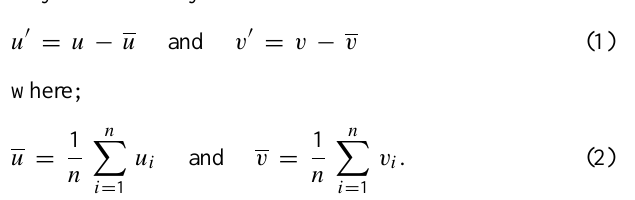
Figure 3- Sections and points of velocity measurement a) the sinusoidal ripple; b) the triangular ripple